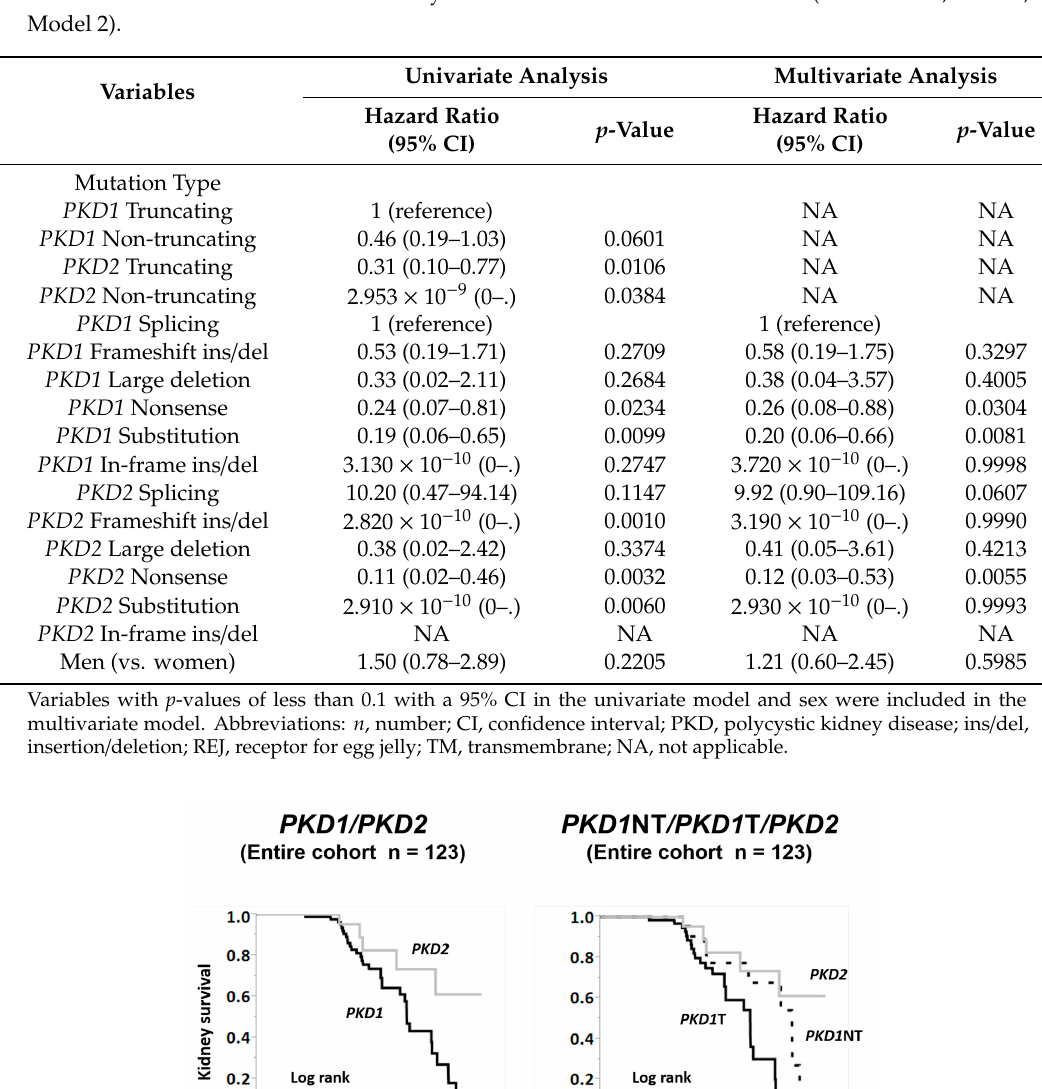
Table 3. Univariate and multivariate analysis of risk factors associated with RRT (entire cohort, n = 123; Model 2).